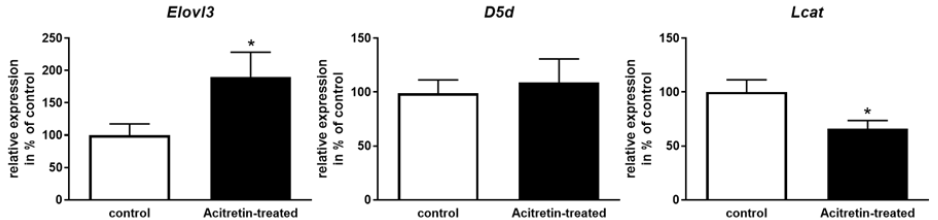
Figure 2. Quantitation of the mRNA level of selected lipid metabolism genes. Mice were treated as described (Figure 1) and one liver lobe harvested for RNA preparation. RNA was subjected to qRT-PCR with Elovl3-, D5d- or Lcat-specific primers. Transcript levels of Gapdh were used for normalization. Data are presented as mean + SEM (n = 6 for Elovl3 in acitretin-treated mice, n = 7 for all other groups; Student’s unpaired t -test; * p < 0.05).